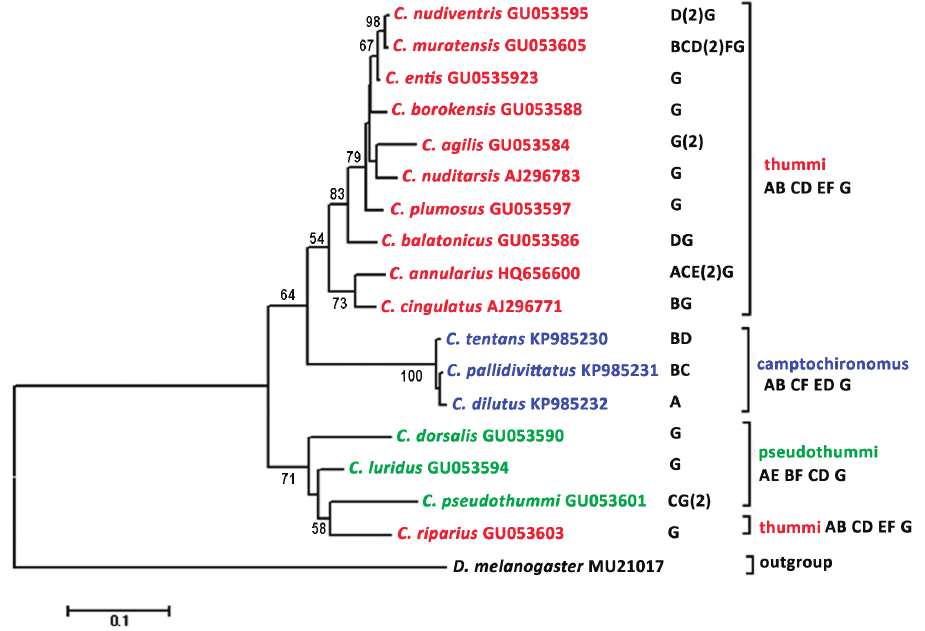
Figure 5. NJ tree based on maximum likelihood distances for ITS1 and 5,8S rDNA sequences from the genus Chironomus species. Drosophila melanogaster is used as an outgroup species. Maximum likelihood bootstrap values (1000 replicates) (> 50%) are shown next to the nodes. NORs chromosomal arms loca- tion, arm combinations and name of cytocomplexes are listed at the